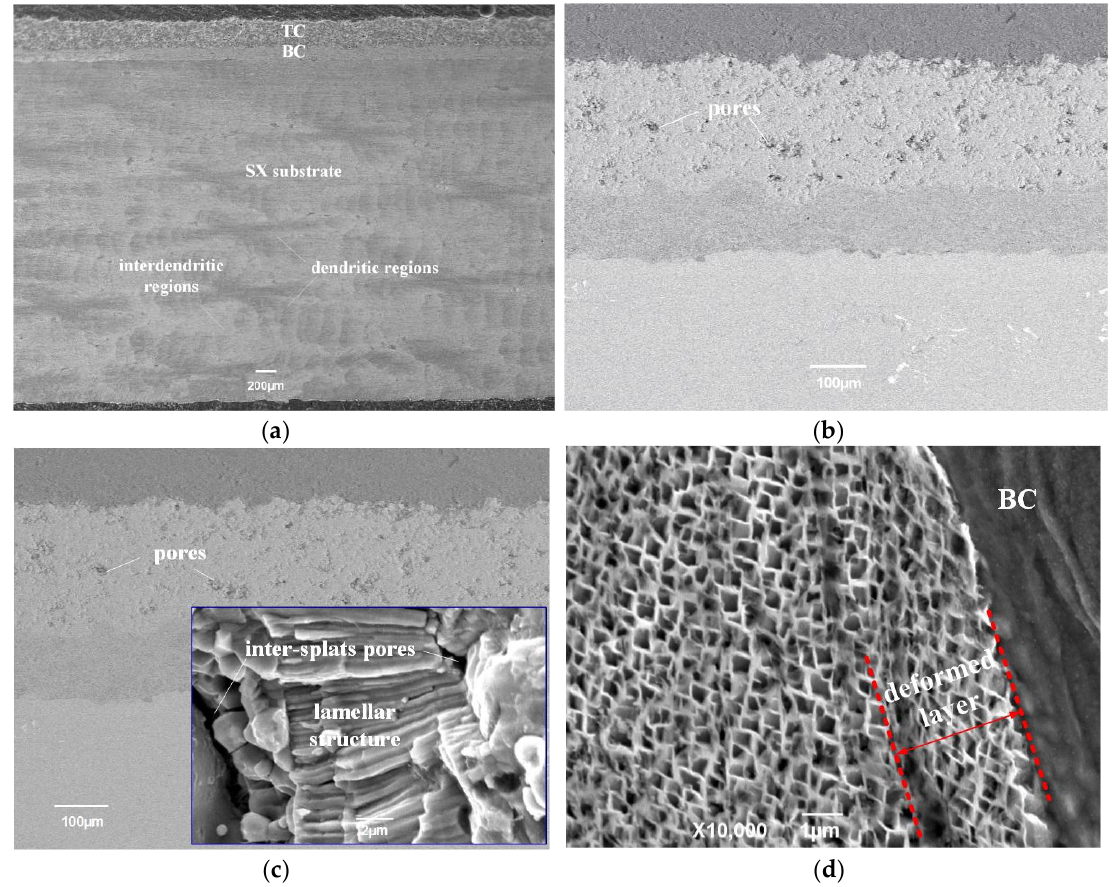
Figure 3. Secondary electron (SE) image ( a ) and ( b ) backscattering electron (BSE) enlarged image of TBCs/ SX superalloy system; ( c ) fracture microstructure of as-sprayed coating; ( d ) SX superalloy microstructure close to the interface.